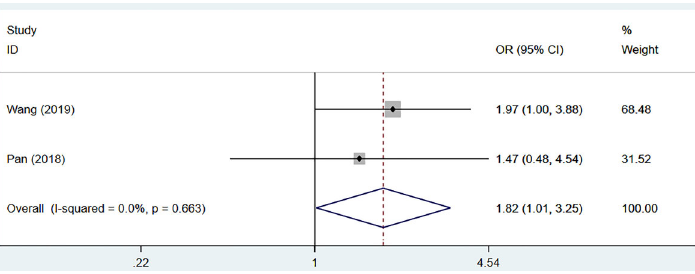
Figure 5. Forest plot of the relationship between preoperative systemic immune-in fl ammation index and microvascular invasion. See Supplementary Table S2 for reference